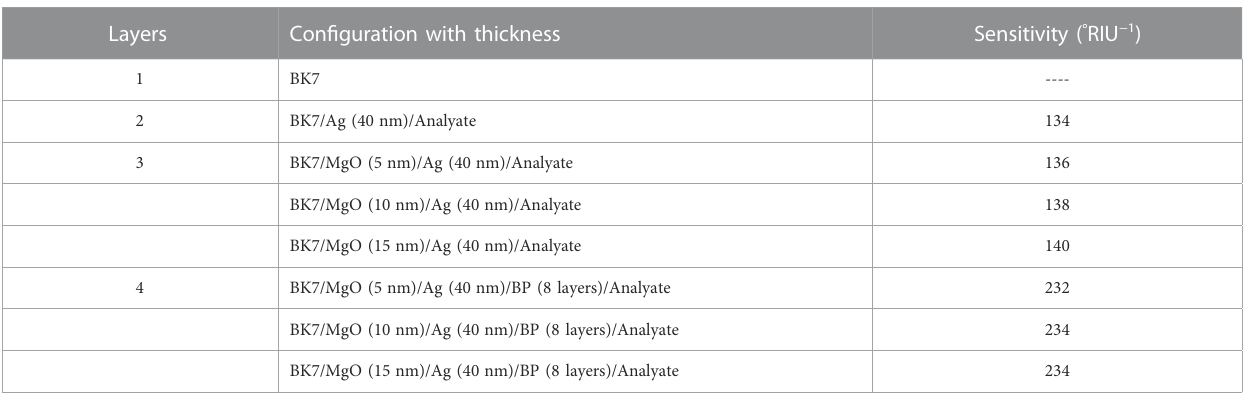
TABLE 2 Sensitivity outcomes layer by layer with several con fi guration.